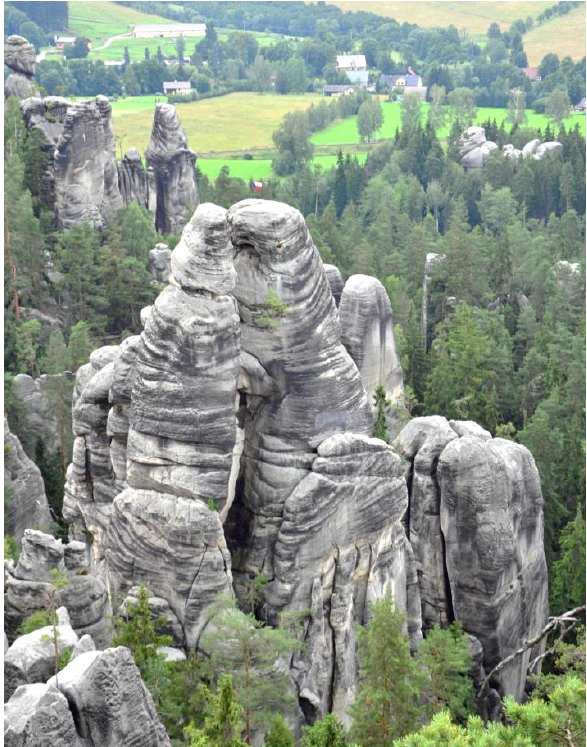
Figure 1. Adršpach rocks with Milenci rock formation in the middle and smaller Uhlířská rock pillar on the right period without snow cover. To obtain a high density point cloud, the drone was flying about 40 meters above the